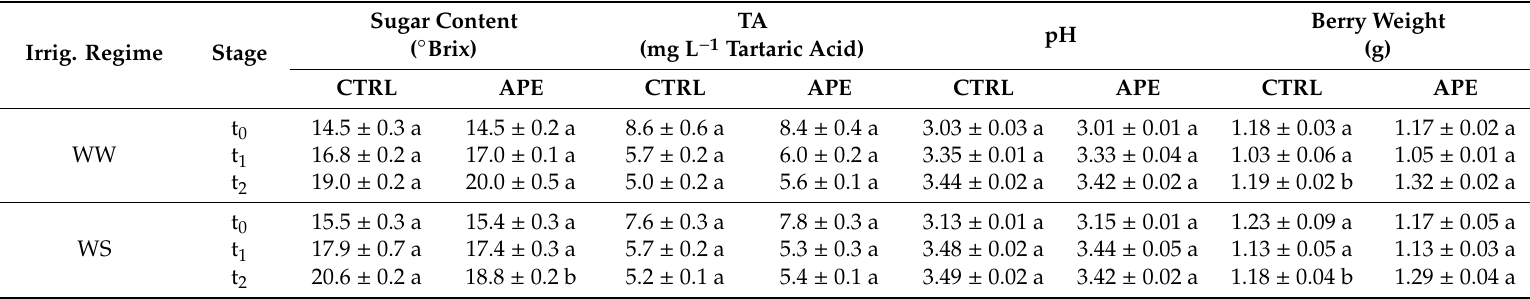
Table 4. Phenolic maturity. Total anthocyanin (Tot. Anth.), extractable anthocyanin (Extr. Anth.), total polyphenol (Tot. Polyp.), and extractable polyphenol (Extr. Polyp.) contents of V. vinifera treated with A. platensis F&M-C256 extract (APE) and control plants (CTRL), under two water regimes (well-watered, WW; water-stressed, WS). Assessments were attended at t 0 , t 1 , and t 2 . One-way ANOVA was performed on data (mean ± SE, n = 10). Within the same row and parameter, di ff erent letters mean significant di ff erences among APE and CTRL (LSD test, p ≤ 0.05). Irrig.